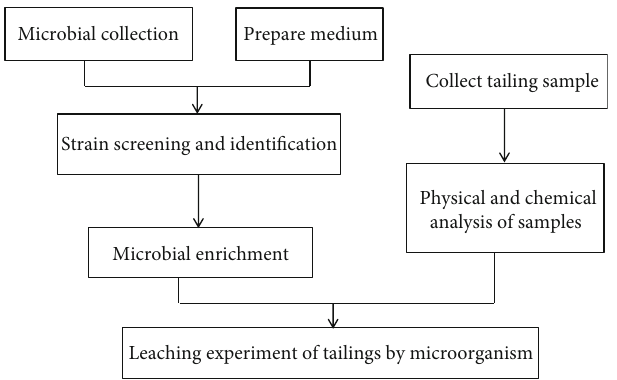
Figure 2: Technical fl ow of heavy metals from bioleaching